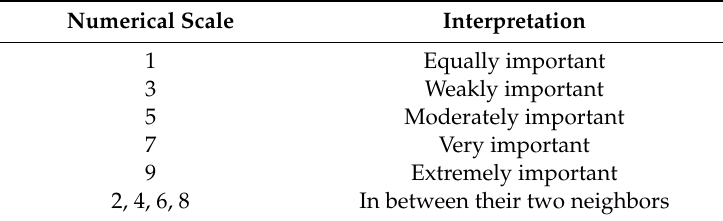
Table 1. Numerical scale of relative